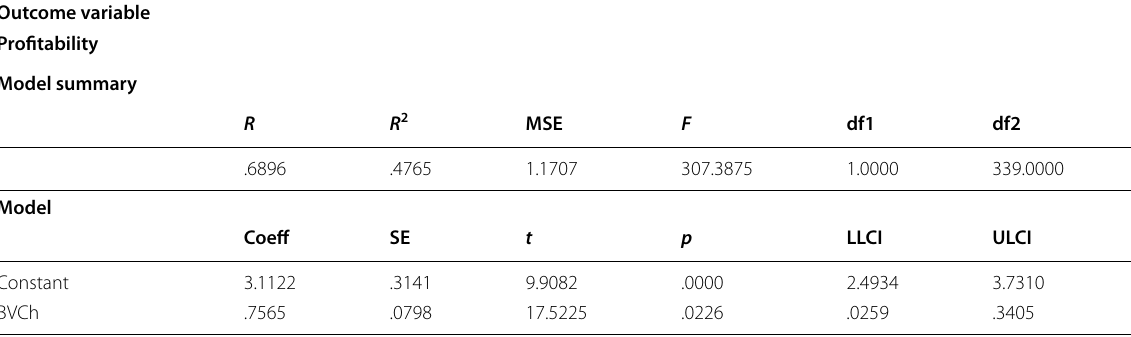
Table 9 The output of profitability. Source: Author’s calculations using Hayes Process Macro Model 5 Outcome variable